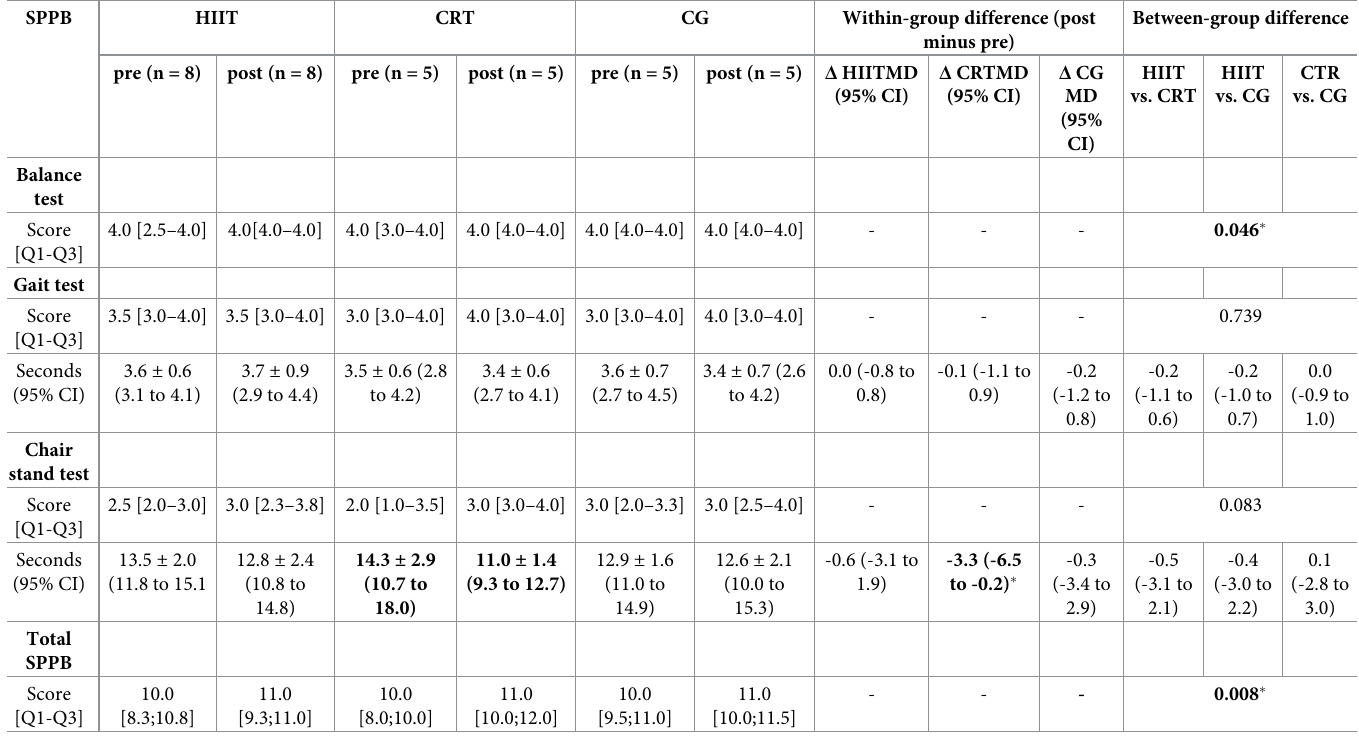
Table 5. Impact of interventions on short physical performance battery in heart failure patients.